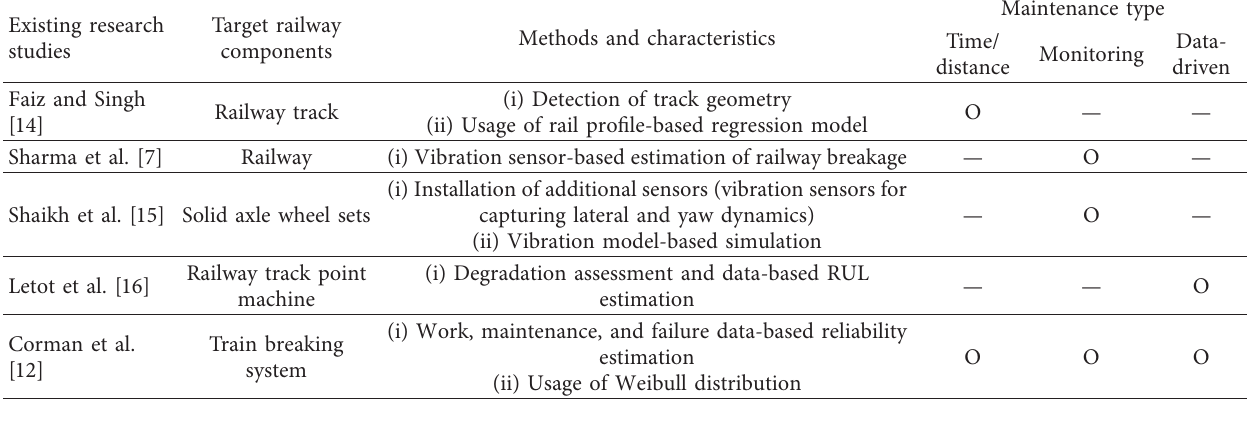
Table 1: Existing time, monitoring, and data-driven maintenance applications in rail systems.